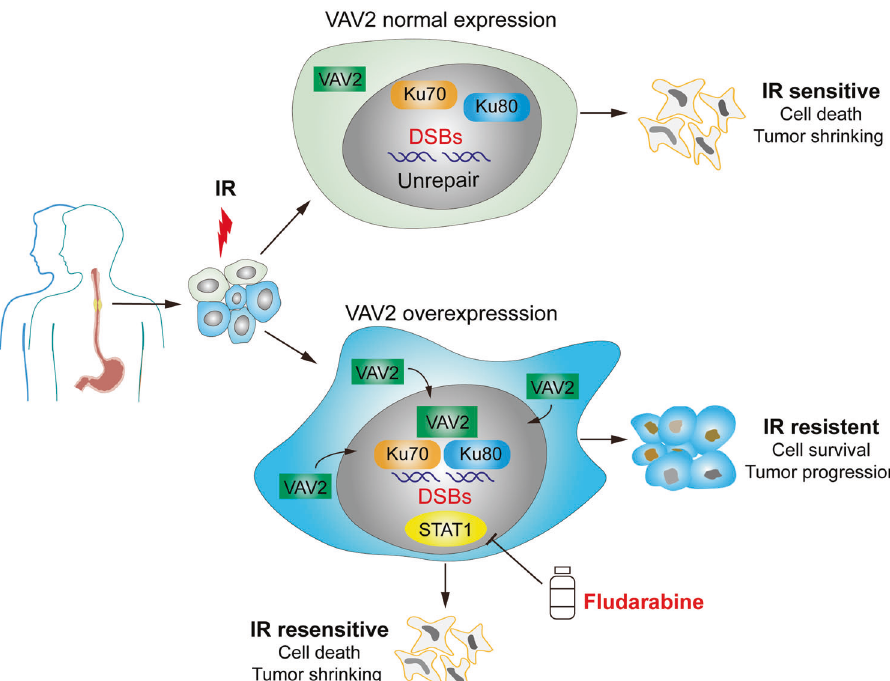
Fig. 7 The schematic illustration for the possible mechanisms of VAV2-mediated radioresistance of ESCC cells and Fludarabine as a radiosensitizer. Overexpressed VAV2 in cancer cells increases VAV2-Ku70/Ku80 complex formation and activates signal transducer and activator of transcription 1 (STAT1) signaling, which enhances the ability of cells to repair DNA damage caused by ionizing radiation (IR) and thus promotes cancer growth. However, Fludarabine can inhibit STAT1 activity and reverses the vulnerability of VAV2-overexpressing cancer cells to IR. On the other hand, cancer cells without VAV2 overexpression are relatively sensitive to